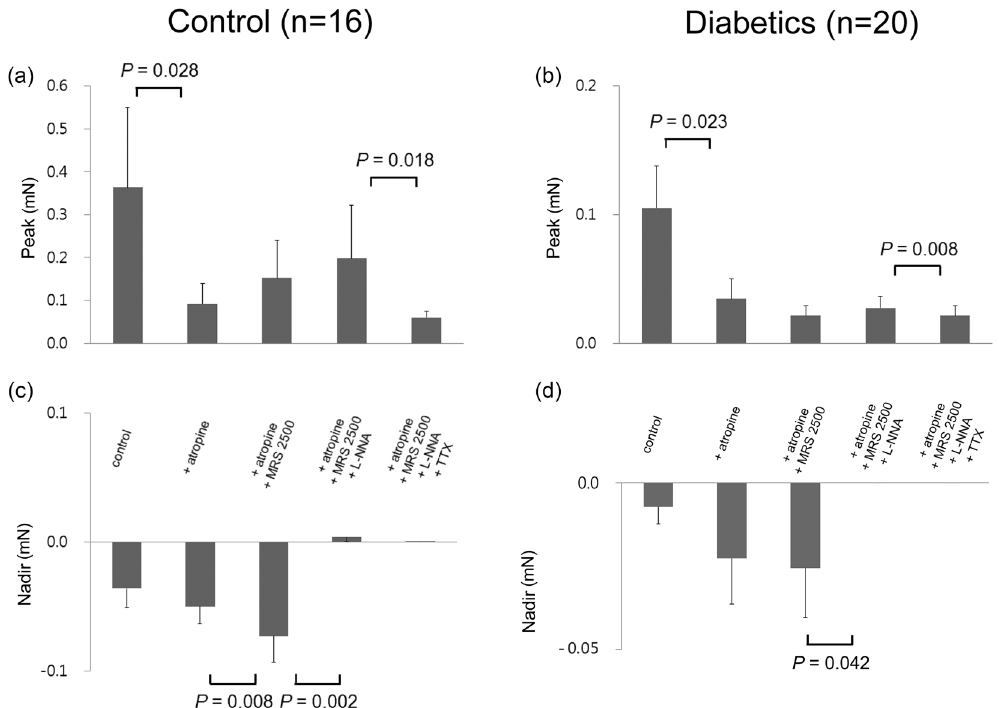
Figure 3. Electrical field stimulation (EFS)-induced response of distal gastric circular muscle strips after serial administration of atropine, MRS2500, N-nitro-L-arginine (L-NNA), and tetrodotoxin (TTX). ( a and b ) Atropine decreased the peak and TTX decreased the peak further in both the control subjects and diabetic patients. ( c ) MRS2500 increased the nadir but L-NNA abolished relaxation in the control subjects. ( d ) Also in the diabetic patients, L-NNA abolished relaxation. The Wilcoxon signed-rank test was used to evaluate the effects of each drug by compare values to the previous one.